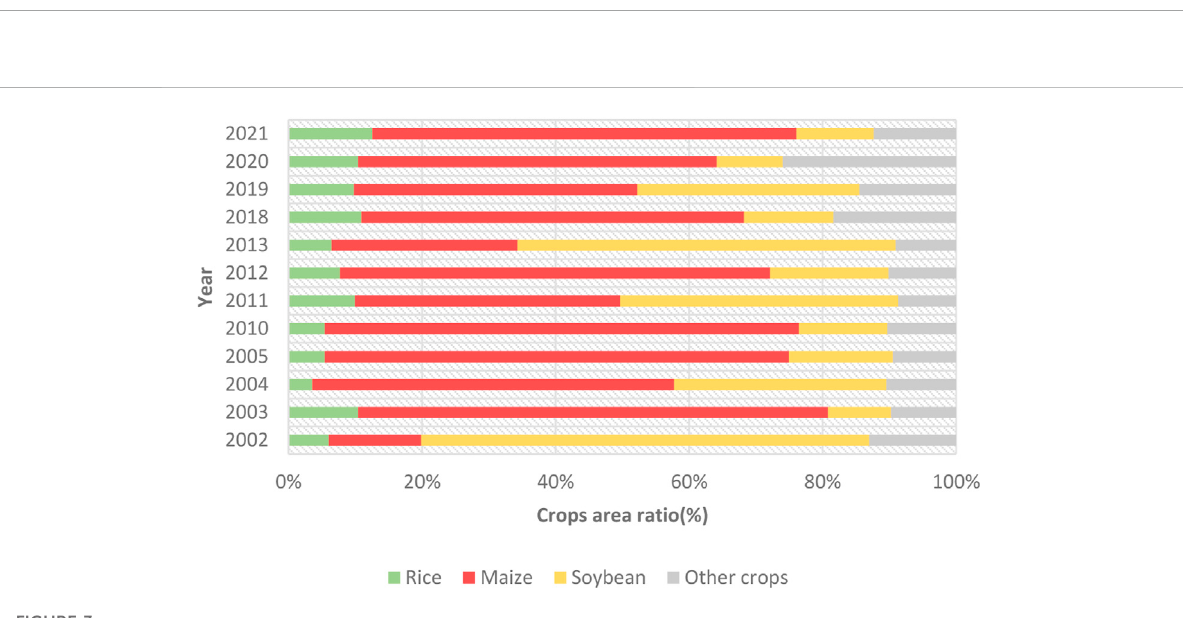
FIGURE 2 Information remapping rules. (A) Crop classi fi cation data during 2017 – 2021; (B) information remapping rules between crop-change information Tupuunits and cropping patternclassi fi cation system. RCC,rice continuous cropping; MCC,maizecontinuous cropping;SCC, soybean continuous cropping; RMR, rice – maize rotation; RSR, rice – soybean rotation; MSR, maize – soybean rotation; MP, mixed cropping